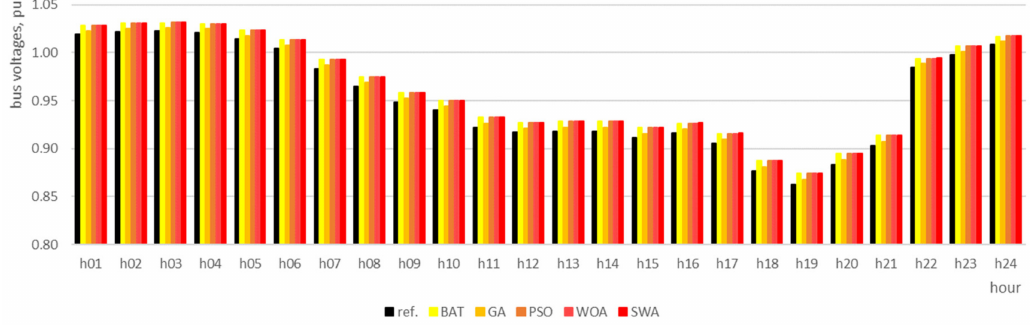
Figure 28. Voltage improvement after compensation for bus 215, low voltage, the 215-bus network. Table 15. Hourly reference voltage values for bus 215 and percent improvements after compensation, the 215-bus